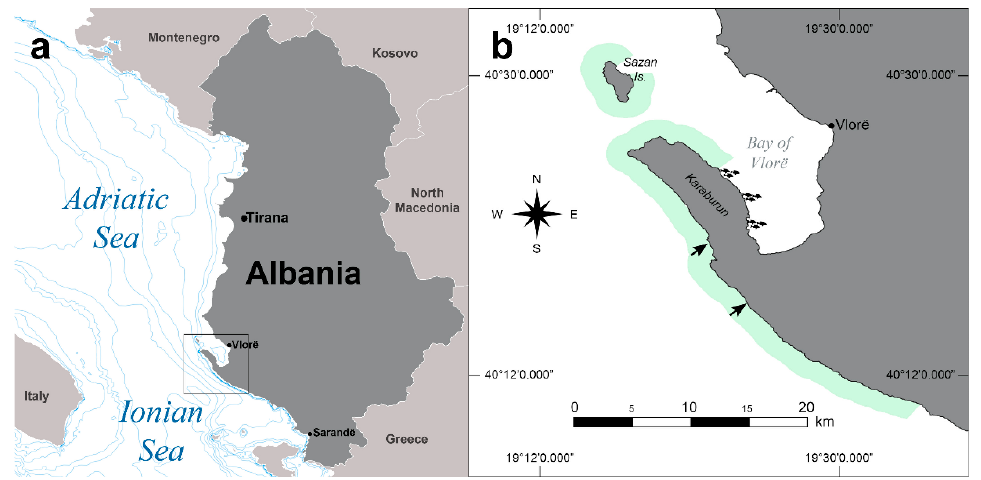
Figure 1. ( a ) Map of Albania highlighting the study area enlarged in ( b ). ( b ) Territory of the Marine National Park Karaburun-Sazan. In the map, the rough location of the 2 caves (arrows) equipped with infrared cameras to monitor Mediterranean monk seals' effective use along the western coast of the park is represented. The position of the fish farms in the area (fish-shaped icons) is located on the eastern coast of the Karaburun Peninsula (Bay of Vlorë). The exact geographical position of the caves is not reported to protect the locations.